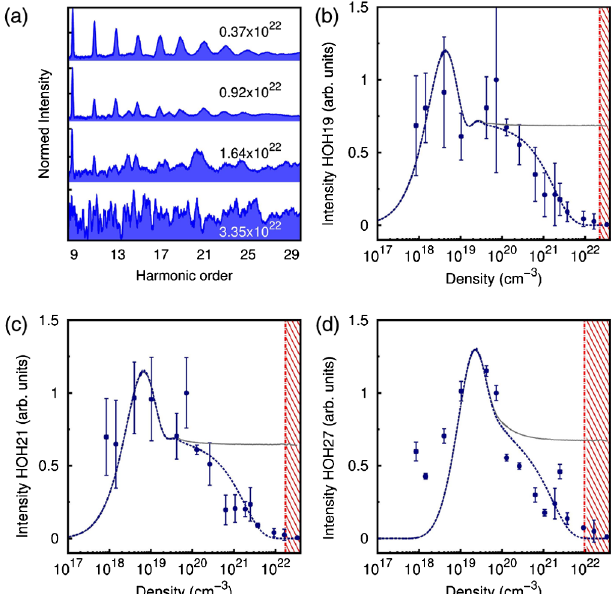
FIG. 3. Observing the perturbation of electronic trajectories. (a) Spectra of the harmonic radiation for different densities of the target. (b) – (d) Density-mapped harmonic radiation of the 19th, 21st, and 27th order, respectively (blue dots). The signal increases for low densities. A loss in the signal of the harmonic radiation is observed for increasing density due to a higher probability of a perturbation of the electronic trajectory by an adjacent molecule. The measured data are compared with a calculation of the harmonic signal as a function of the density for two cases: including (blue line) and excluding (gray line) a perturbation of electronic trajectories. All trajectories are perturbed for densities ρ s corresponding to the excursion distance of the short trajectory, and no harmonic radiation is emitted (red area). Since x increases as a function of the harmonic order, ρ s shifts towards lower values with increasing harmonic